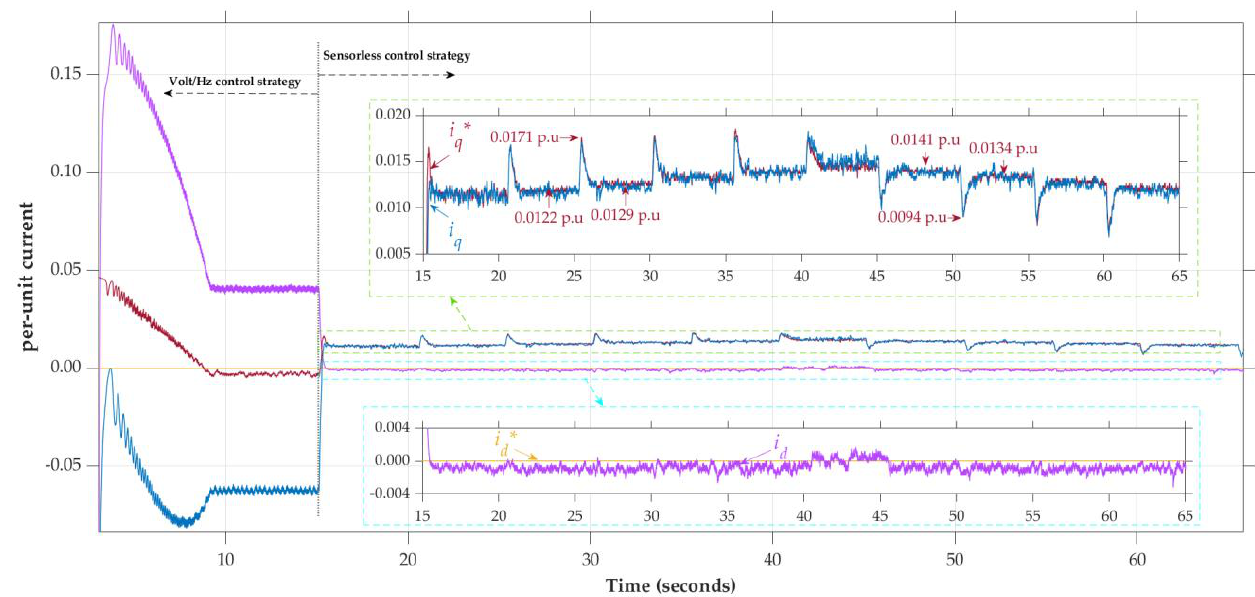
Figure 17. Experimental result for current response in the d-q axis.